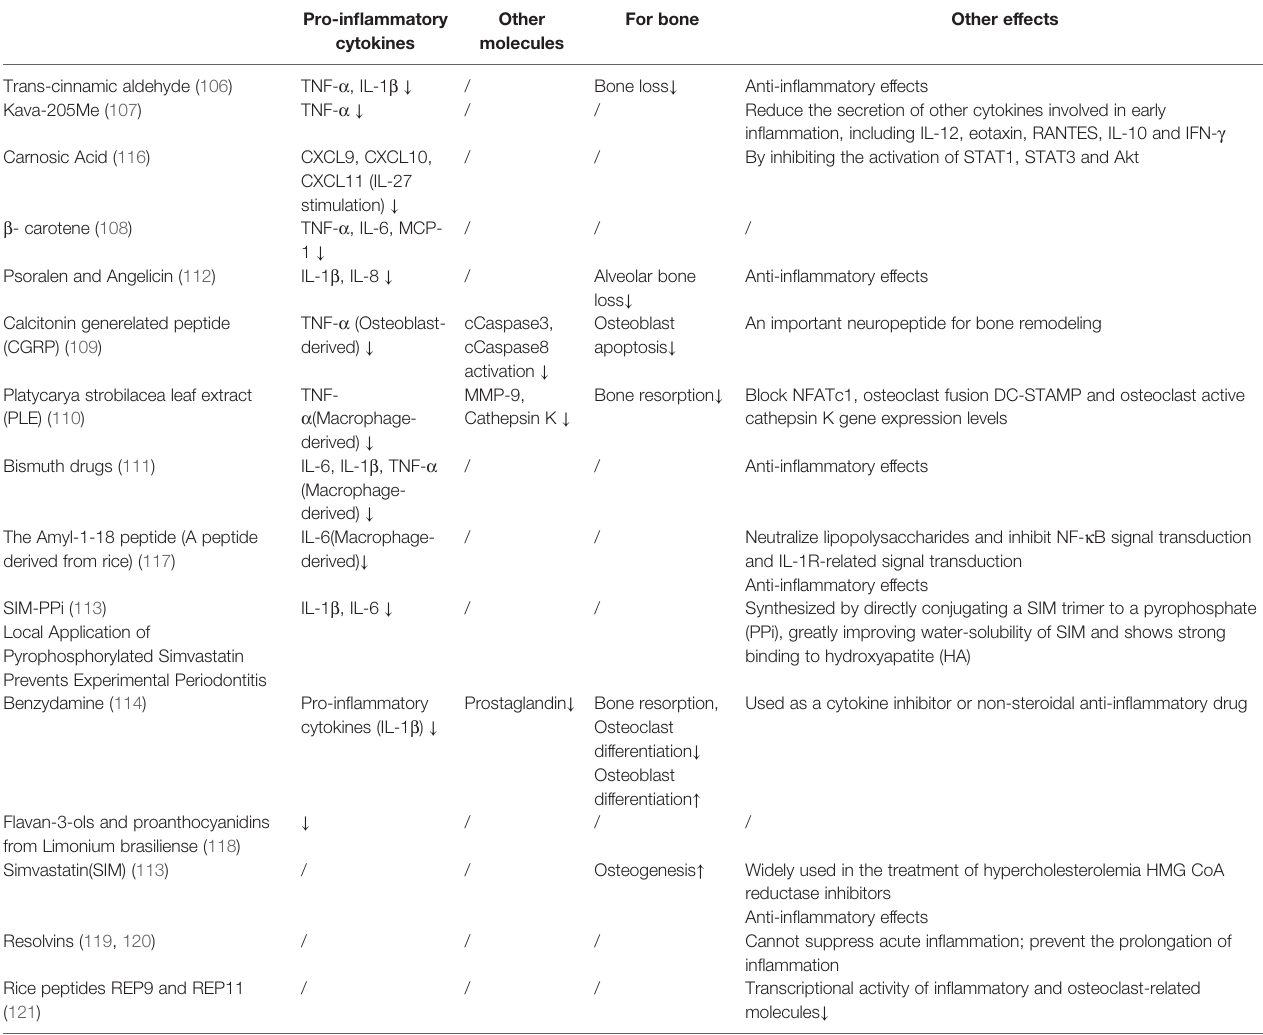
TABLE 2 | Effects of drugs targeting